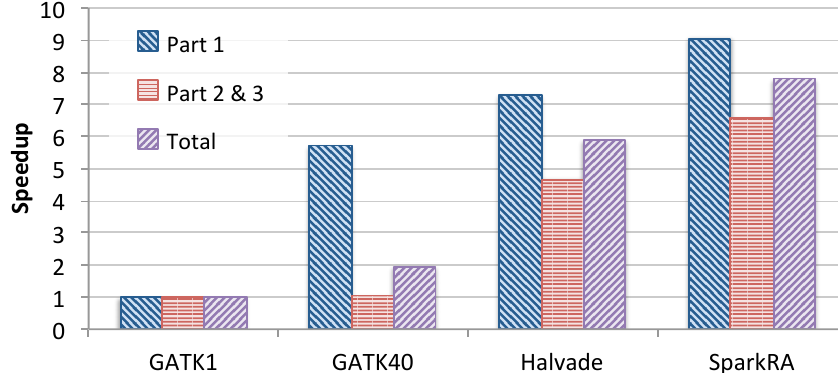
Figure 6. Single-node speedup of 40-thread GATK RNA-seq (GATK40), Halvade-RNA and SparkRA over single-threaded GATK RNA-seq